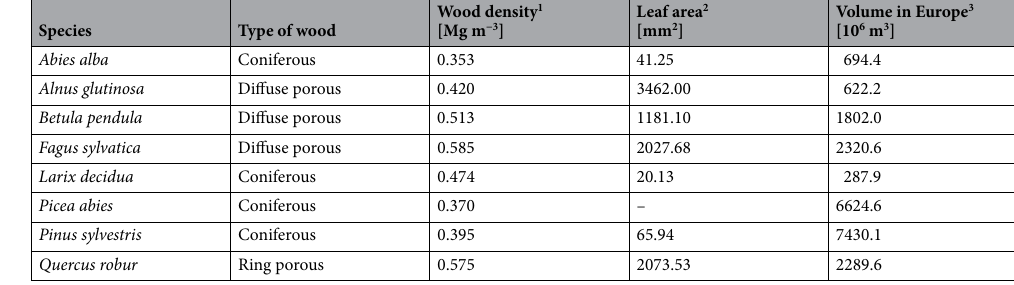
Table 1. Overview of tree species studied and their biological traits. Sources: 1—Wood density database 48,51 , 2—LEDA traits database 52 , no data for P. abies leaf area; 3—total volume of tree stand according to the FAO Global Resources Assessment in 2010 53 —data for countries in temperate and boreal climate, for Alnus , Betula , Larix and Quercus aggregated at the genera